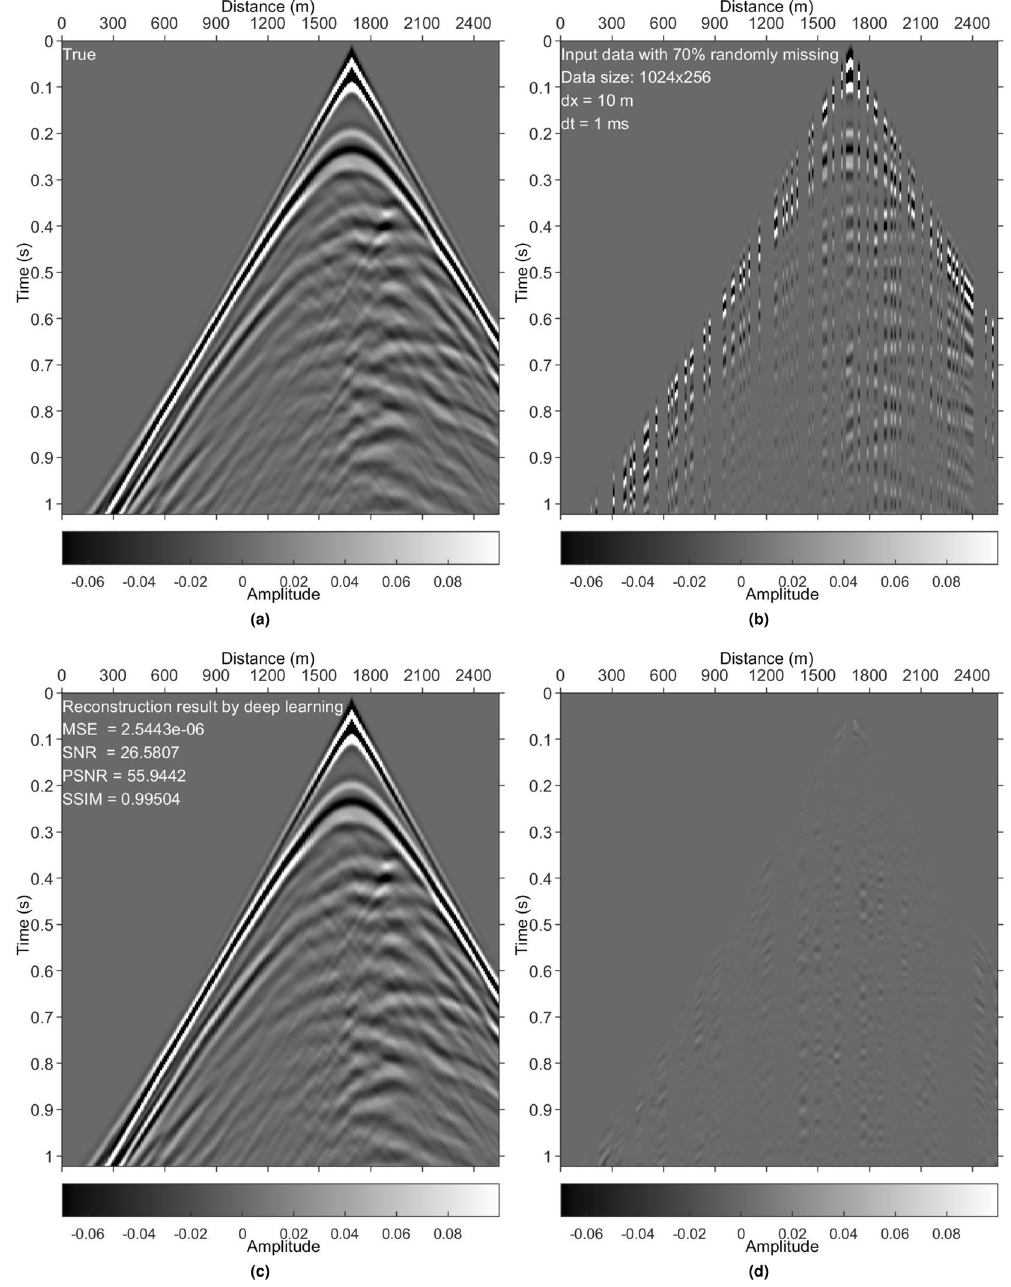
Figure 8. Results on a test data set generated with the Marmousi2 model. ( a ) True data. ( b ) Irregularly sampled data with 70% missing. ( c ) DL reconstruction result. ( d ) Difference between ( a , c